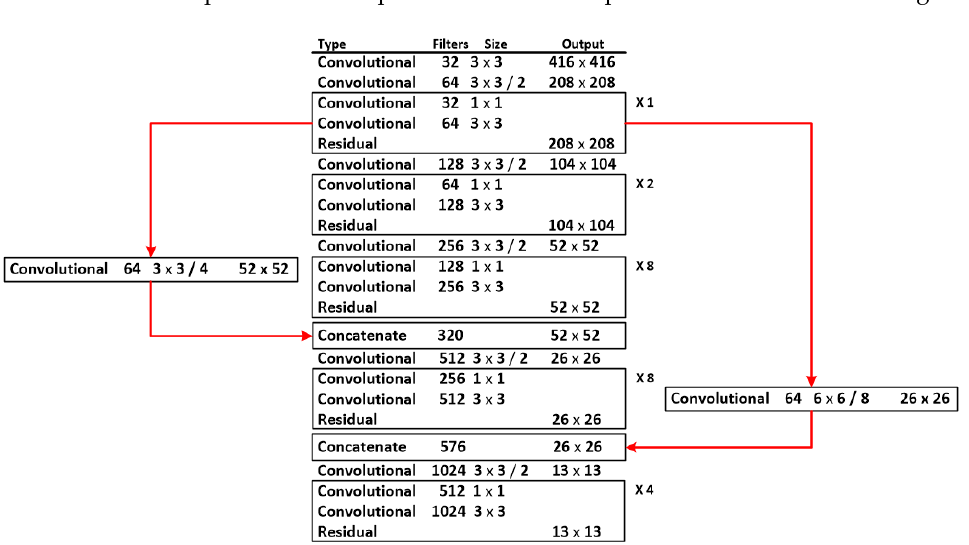
Figure 7. Skip connection network parameters.